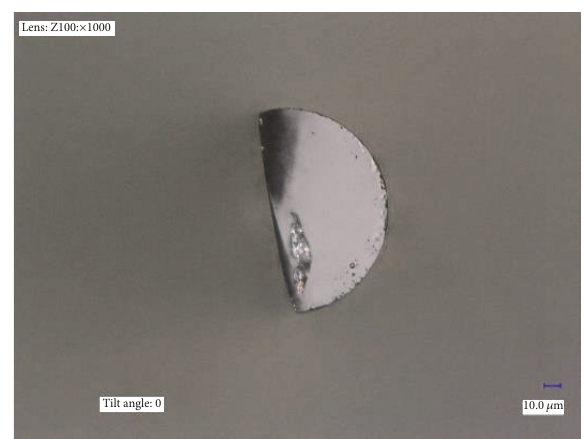
Figure 2: Microscopic image of the D-shaped